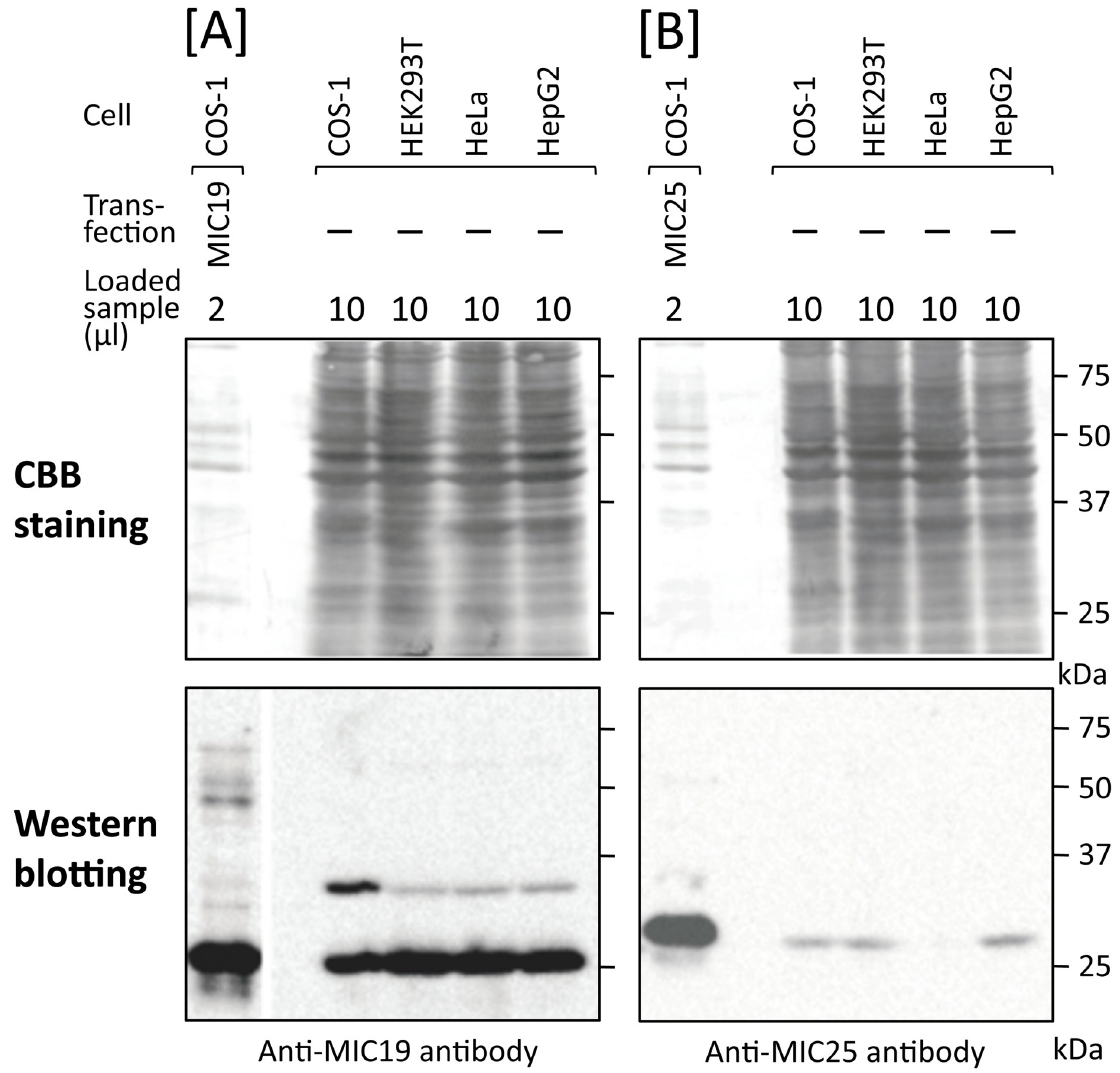
Fig 10. Comparison of the relative amounts of MIC19 and MIC25 expressed in mammalian cells. The expression levels of endogenous MIC25 in four mammalian cell lines (COS-1, HEK293T, HeLa, HepG2 cells) were compared with those of MIC19 by western blotting analysis using tag-free MIC19 and tag-free MIC25 expressed in COS-1 cells as standard proteins. For this analysis, total cell lysates derived from the four cell lines were subjected to western blotting analysis using anti-MIC19 or anti-MIC25 antibodies. A; Expression of MIC19, B; Expression of MIC25, Upper panels; Coomassie-brilliant blue (CBB) staining, Lower panels; Western blotting